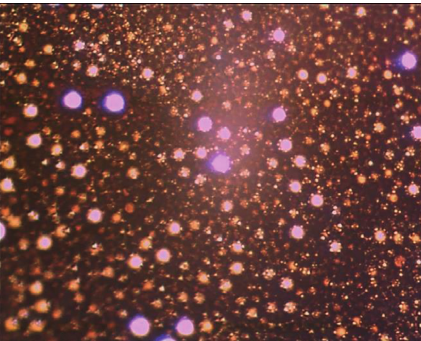
Figure 8: Microscopic image of the extraction process and micelle formation of rhamnolipid.